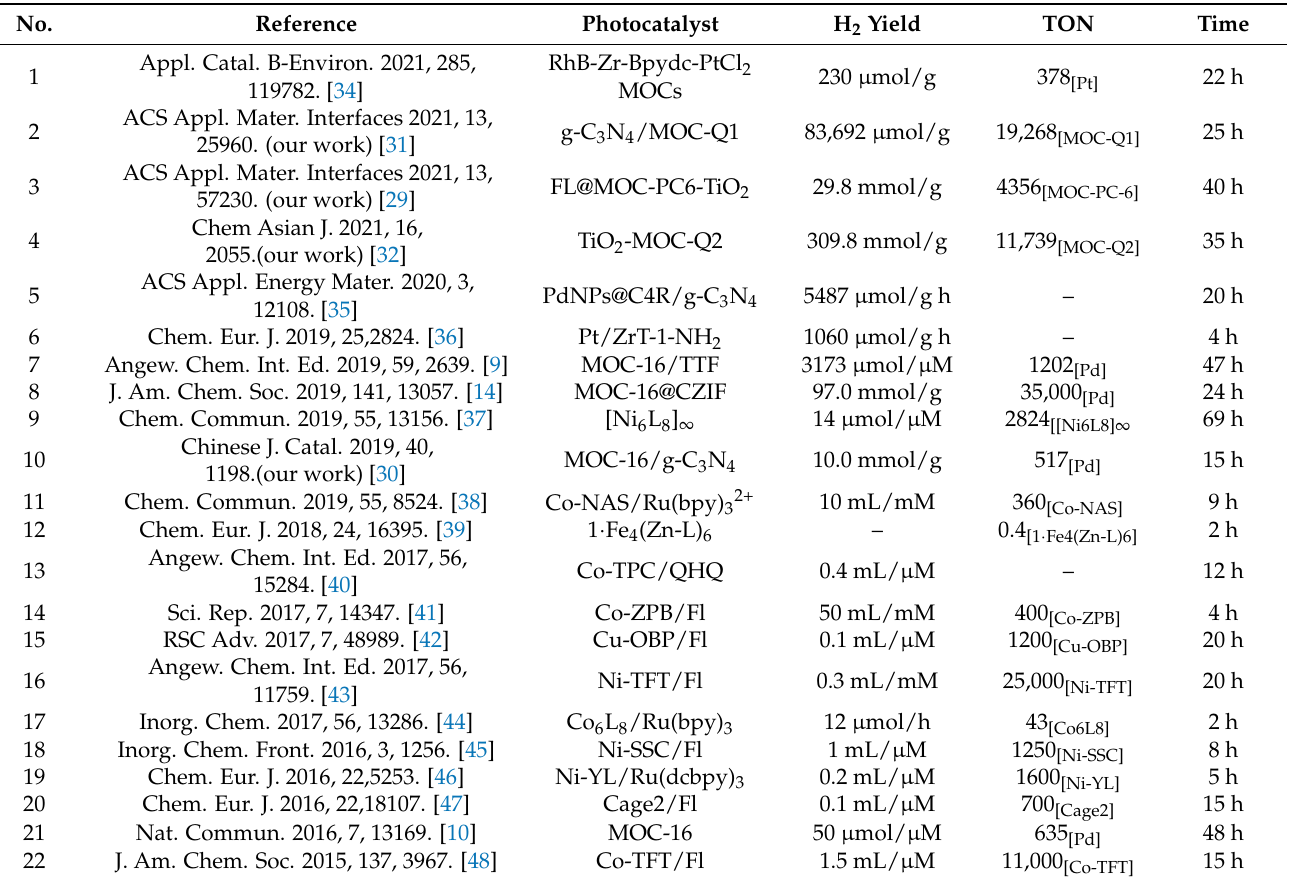
Table 1. Performances of photocatalytic systems based on MOC for visible-light-driven hydrogen evolution in recent